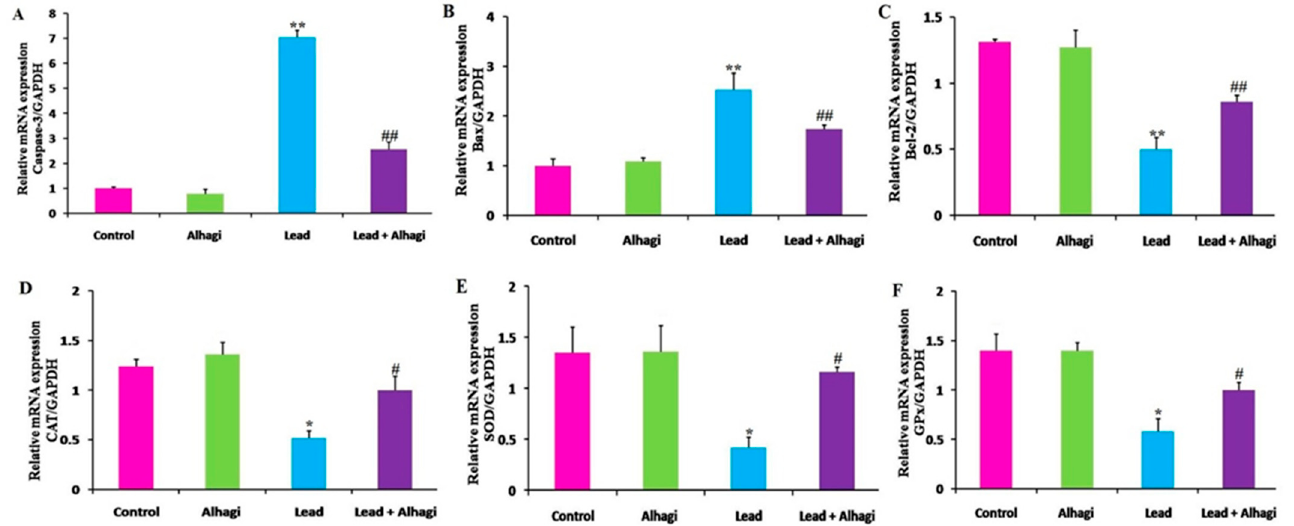
Figure 4. Effect of the A. maurorum extract (300 mg/kg BW, orally) on the mRNA levels of genes related to apoptosis ( A – C ), and oxidative stress ( D – F ) in the brain of rats treated with lead (100 mg/kg BW, orally) daily for 3 months. Caspase-3 ( A ), Bax ( B ), Bcl-2 ( C ), CAT ( D ), SOD ( E ), and GPx ( F ). Data were expressed as mean ± SE, n = 10 for each group. *, ** Significantly different compared to the control group at p < 0.05 and p < 0.01, respectively. #, ## Significantly different compared to the lead-exposed group at p < 0.05 and p < 0.01, respectively.